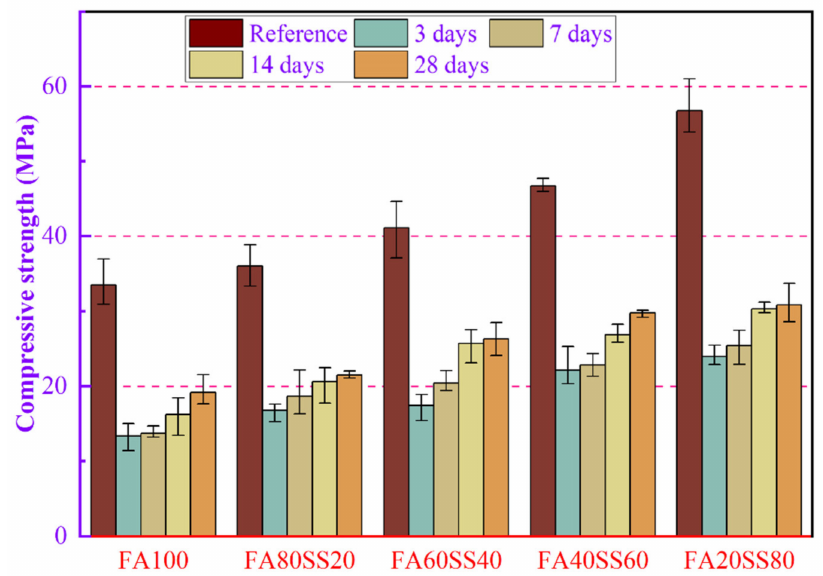
Figure 6. Compressive strength of precast geopolymers at 3 days and after different periods of